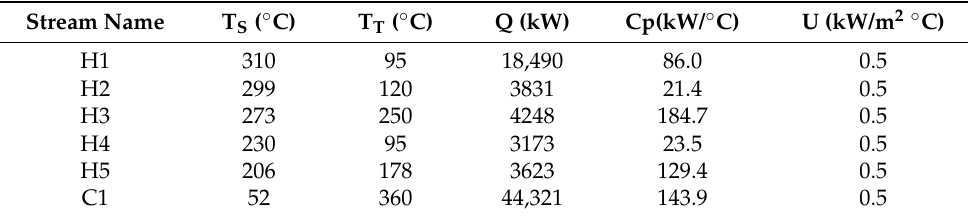
Figure 14. The original structure of HEN for case study 2. Table 4. The process data of case study 2.